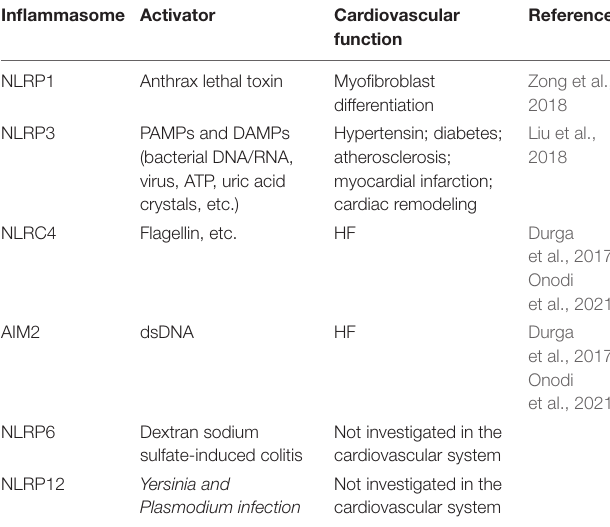
TABLE 1 | Different types of